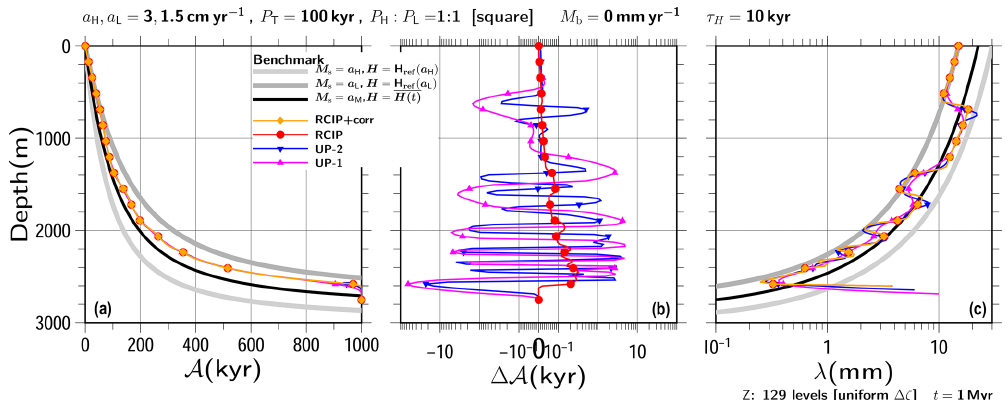
Figure 12. Same as Fig. 7 but for the results of non-steady thickness experiments conducted with the response timescale set as τ H = 10kyr. The reference thickness values H for the benchmark profiles are explained in the text.